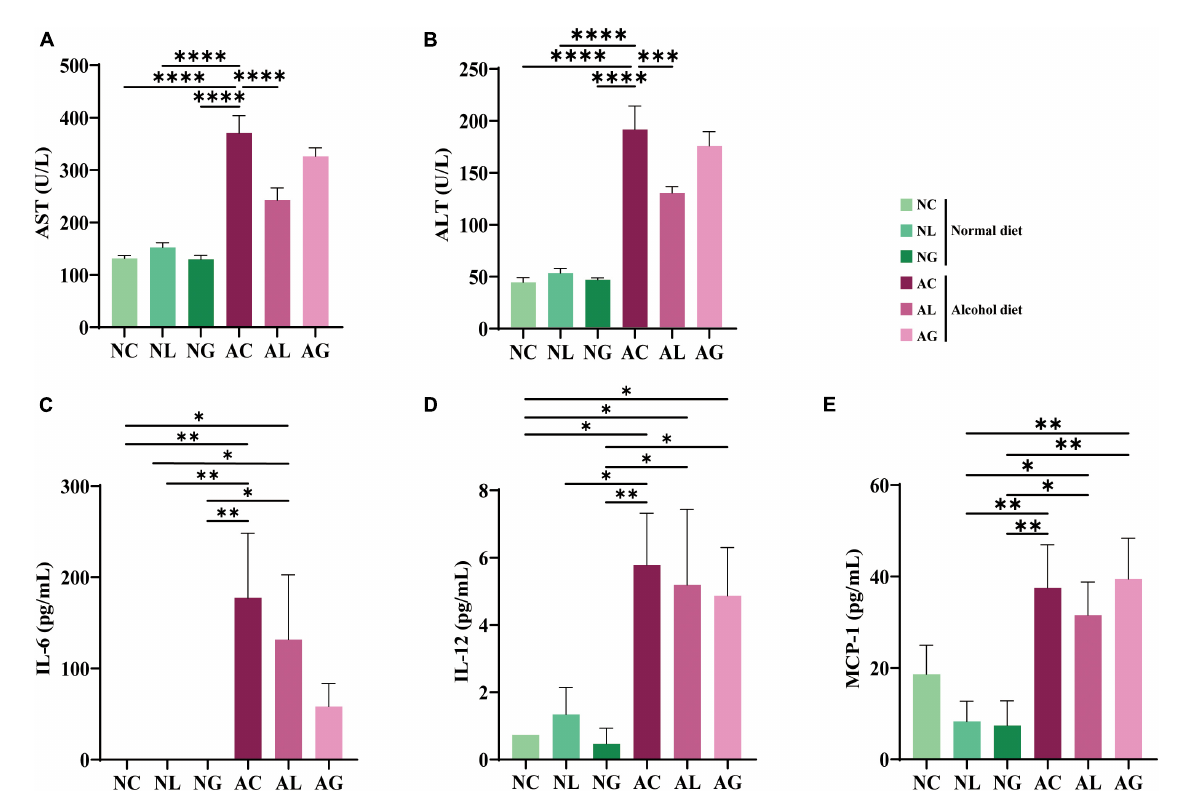
FIGURE2 Serum levels of ALT, AST, and inflammatory cytokines in mice fed with normal and alcohol diet. (A) ALT, (B) AST, and inflammatory cytokines (C) IL-6, (D) IL-12, and (E) MCP-1. The data were analyzed by performing ordinary one-way ANOVA followed by Fisher’s LSD test. Data are expressed as mean ± standard error of mean (SEM), ∗ p < 0.05, ∗∗ p < 0.01, ∗∗∗ p < 0.001, ∗∗∗∗ p < 0.0001. AST, aspartate transaminase; ALT, alanine aminotransferase; IL, interleukin; MCP, monocyte chemotactic protein; NC, normal diet group; NL, normal diet and Lactiplantibacillus ( Lp .) plantarum DSR J266 + Levilactobacillus ( Lv .) brevis DSR J266 group; NG, normal diet and Lacticaseibacillus ( Lb .) rhamnosus GG group; AC, alcohol diet group; AL, alcohol diet and Lp . plantarum DSR J266 + Lv . brevis DSR J301 group; AG, alcohol diet and Lb. rhamnosus GG group; LSD, least significant